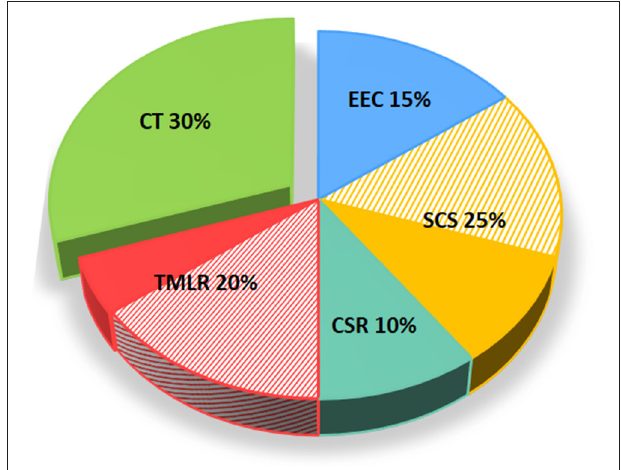
FIGURE 2 | Meta-analyses and outcomes of non-pharmacological treatment options for refractory angina as per guidelines. The figure depicts the number and outcomes of available MTA for each non-pharmacological treatment options for RA including EEC, SCS, and CSR, in addition to CT. Positive MTA are represented with full color while those negatives are depicted with stripes. CSR, coronary sinus reducer; CT, cell-based therapy; EECP, enhanced